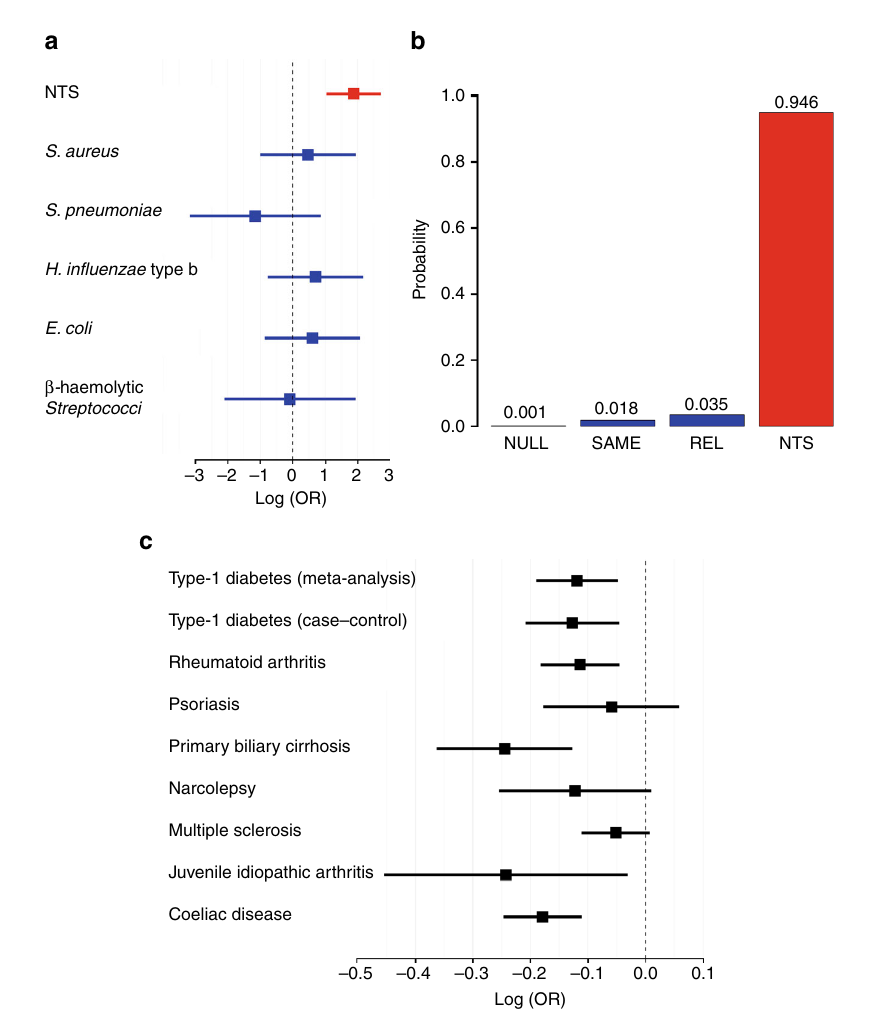
Fig. 3 a STAT4 association with major bacterial pathogens in Kenyan children. Log-transformed odds ratios and 95% con fi dence intervals of rs13390936 association (recessive model) in Kenyan discovery samples. b Posterior probabilities of models of association at rs13390936: NULL, no association with any bacterial pathogen; SAME, the same effect across all bacterial pathogens; REL, related effects across all bacterial pathogens; NTS, a non-zero effect in NTS alone. In a comparison of all possible combinations of rs13390936 association with these pathogens, the model in which NTS alone (highlighted in red) is associated with rs13390936 is the most probable (Bayes factor cf. NULL = 1327). c STAT4 association with autoimmune disease in populations of European ancestry. Log-transformed odds ratios and 95% con fi dence intervals of rs16833239 (in perfect linkage disequilibrium with rs13390936 in European populations; r 2 = 1, D ′ = 1) association (additive model) with autoimmune disease in European